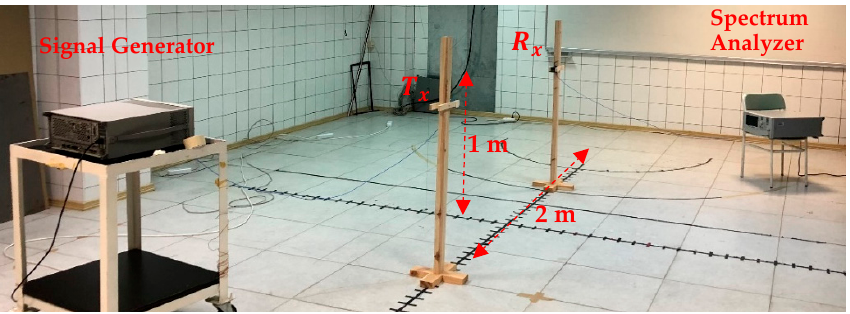
Figure 1. Measurement system.